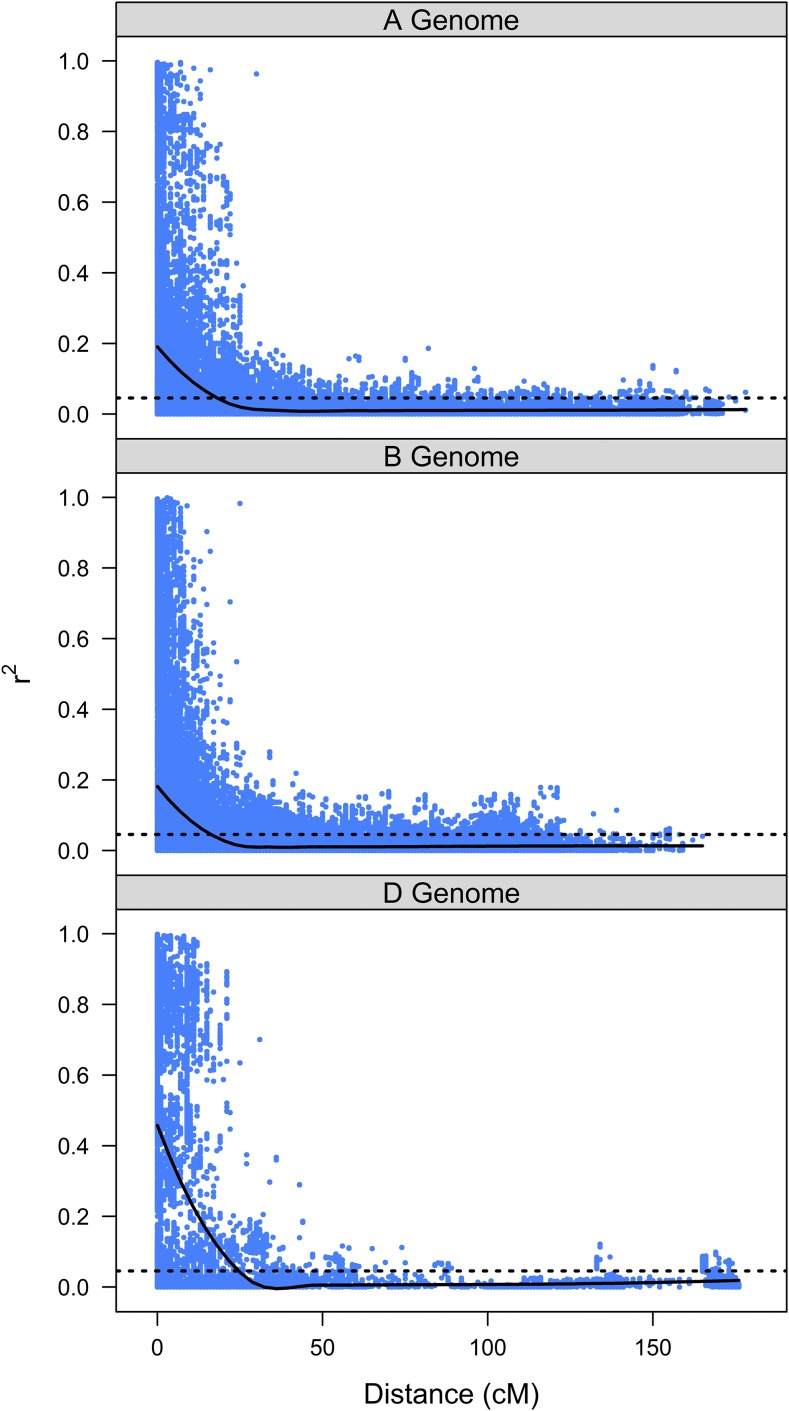
Pairwise LD estimates (r2) plotted against Euclidian pairwise marker distances for markers on the same consensus chromosome for the DArT marker set.